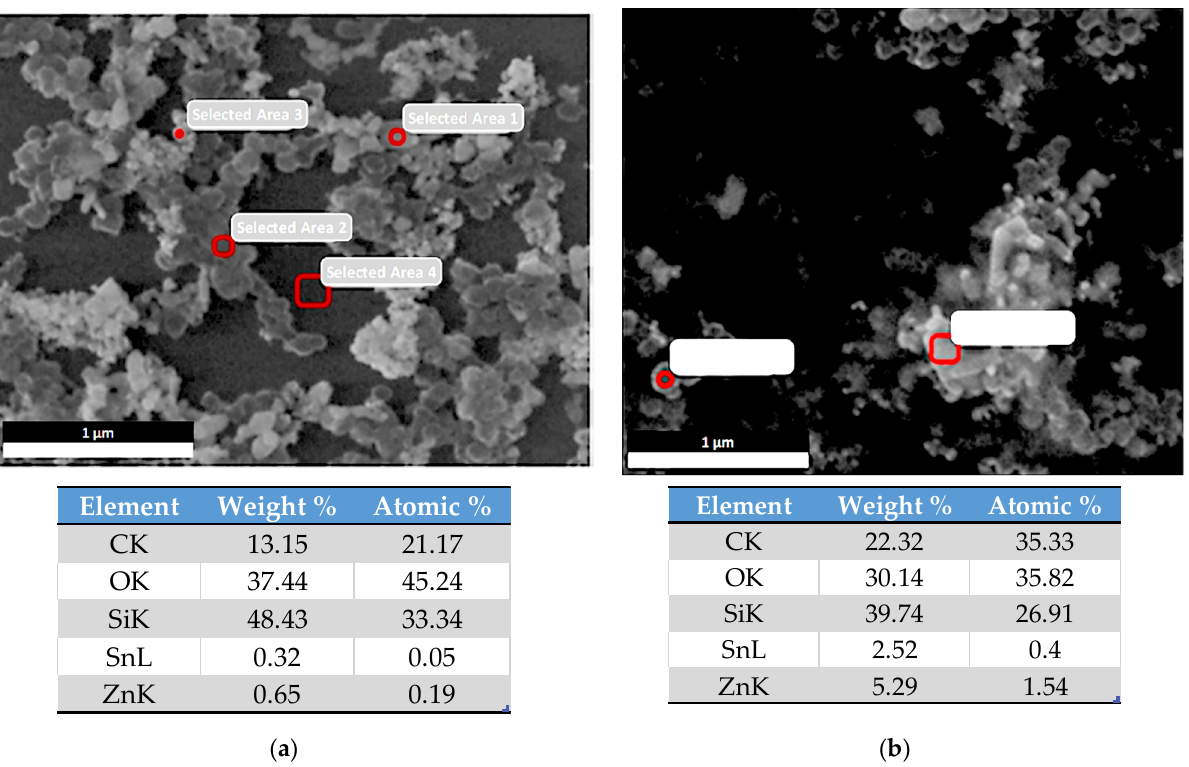
Figure 4. Surface composition of sensitive quaternary layers, depending on the content of nanocarbon material and semiconductor metal oxides obtained by EDX spectroscopy coupled with SEM: ( a ) Sample ”1.5” Ox-SWCNH/SnO2/ZnO/PVP = 1.5/1/1/1, and ( b ) Sample ”3” Ox-SWCNH/SnO 2 /ZnO/PVP = 3/1/1/1.